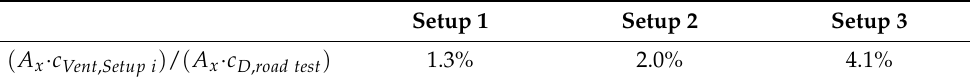
Table 5. Contribution of the ventilation drag to the total aerodynamic drag of the HDV according to Equation (5) of the different wheel setups from Figure 12 in